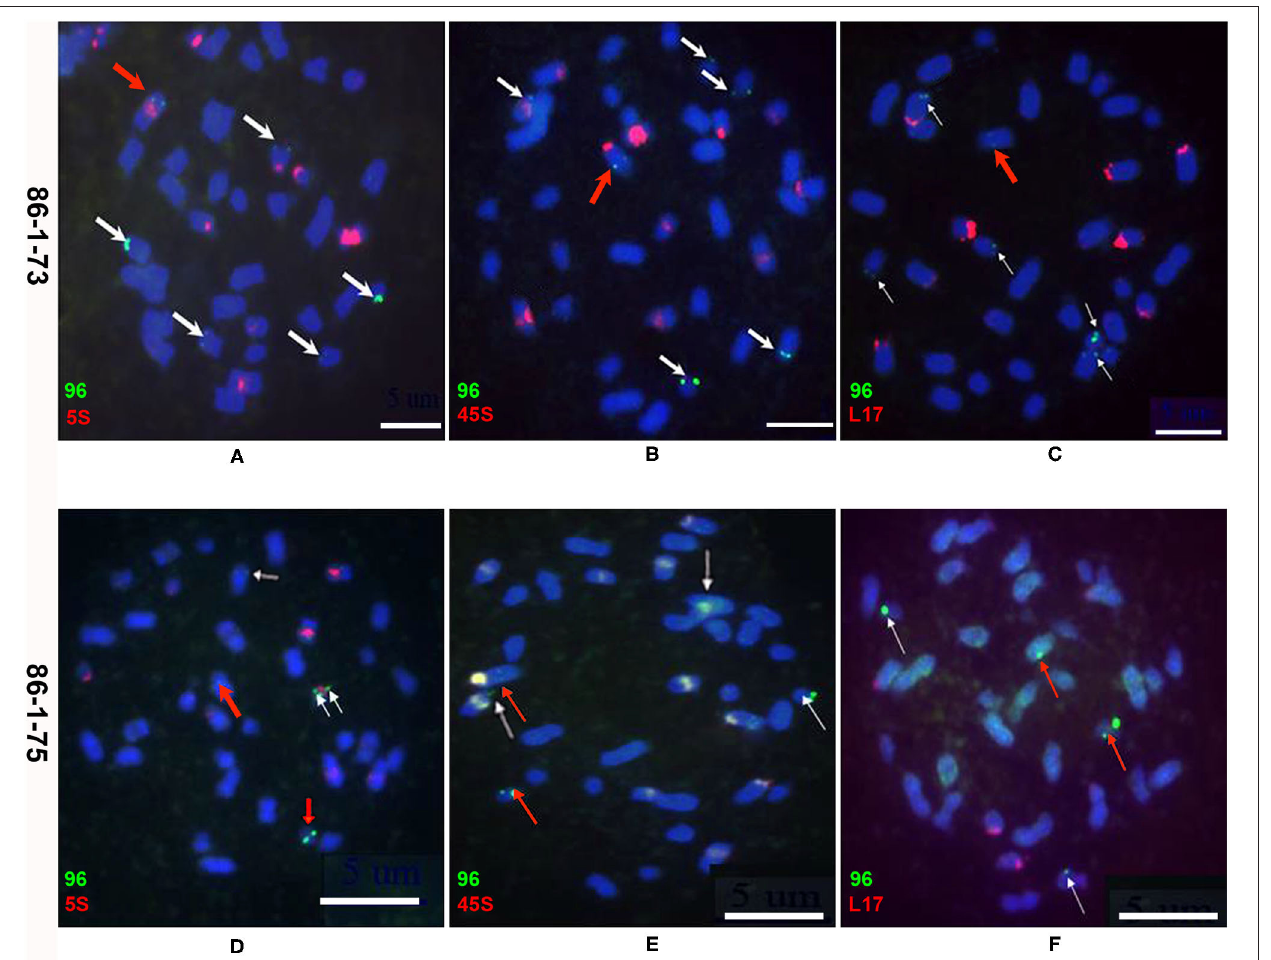
FIGURE 2 | Molecular cytogenetics analysis of chromosome truncations in transgenic plants 86-1-73 and 86-1-75 by FISH. Metaphase chromosomes of root tips were hybridized with a pWY96 probe (96, green). Arrows indicate the chromosomes and the sites of transgene insertions. Scale bar = 5 µ m. (A–C) Six transgenic sites were observed with five distal loci in transgenic plant 86-1-73; (D–F) Five transgenic sites were observed with three distal loci in transgenic plant 86-1-75; pWY96 (A–F) was labeled with Alexa Fluor TM 488-5-UTP (green); 5S (5S rDNA; A,D ), 45S (45S rDNA; B,E ) and KBrB072L17 (L17, C,F ) were labeled with Texas Red-5-dCTP (red). White arrows indicated distal loci and red arrows indicated internal loci.